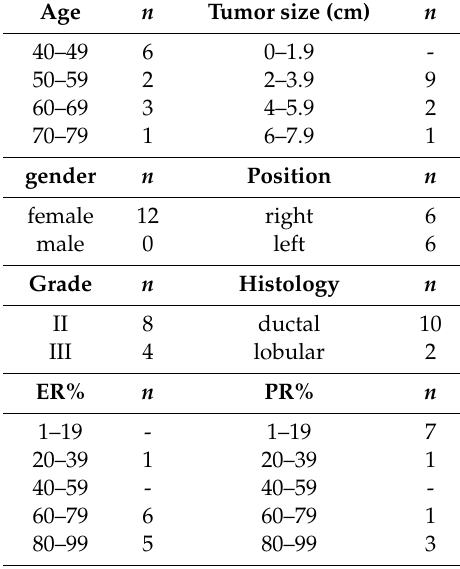
Table 1. Characteristics of the Saudi BC patients and their clinical